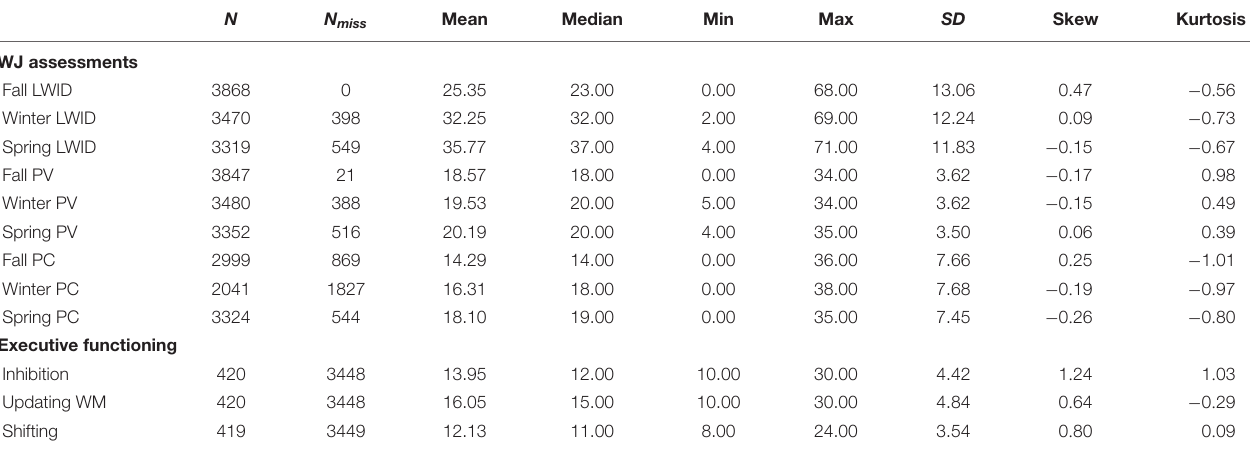
TABLE 1 | Pre-imputation descriptive statistics.